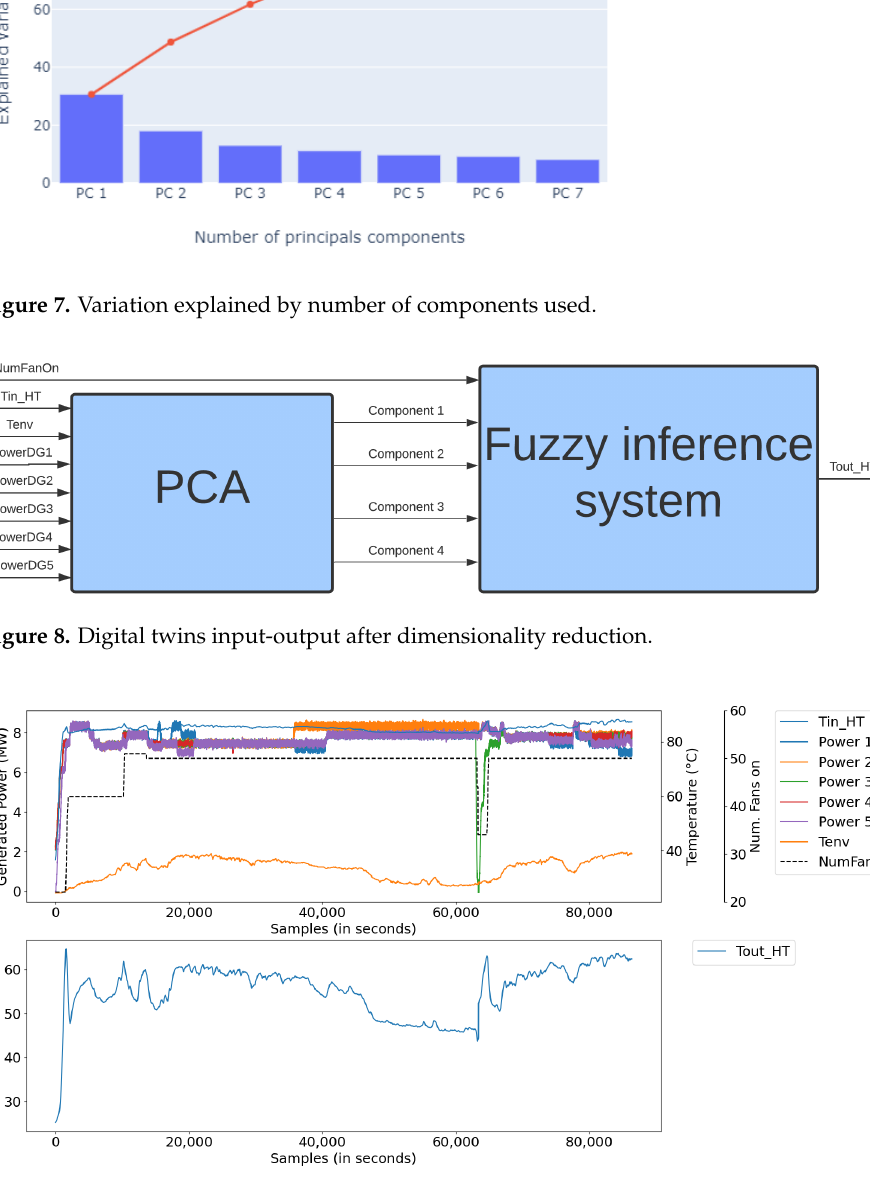
Figure 9. Cooling system